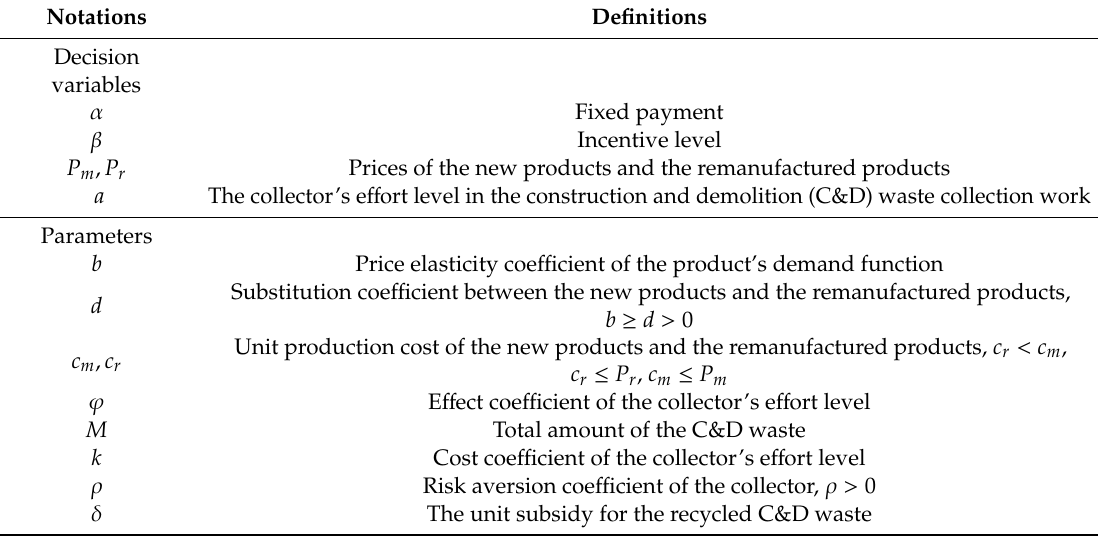
Table 1. Notations and definitions of the decision variables and the